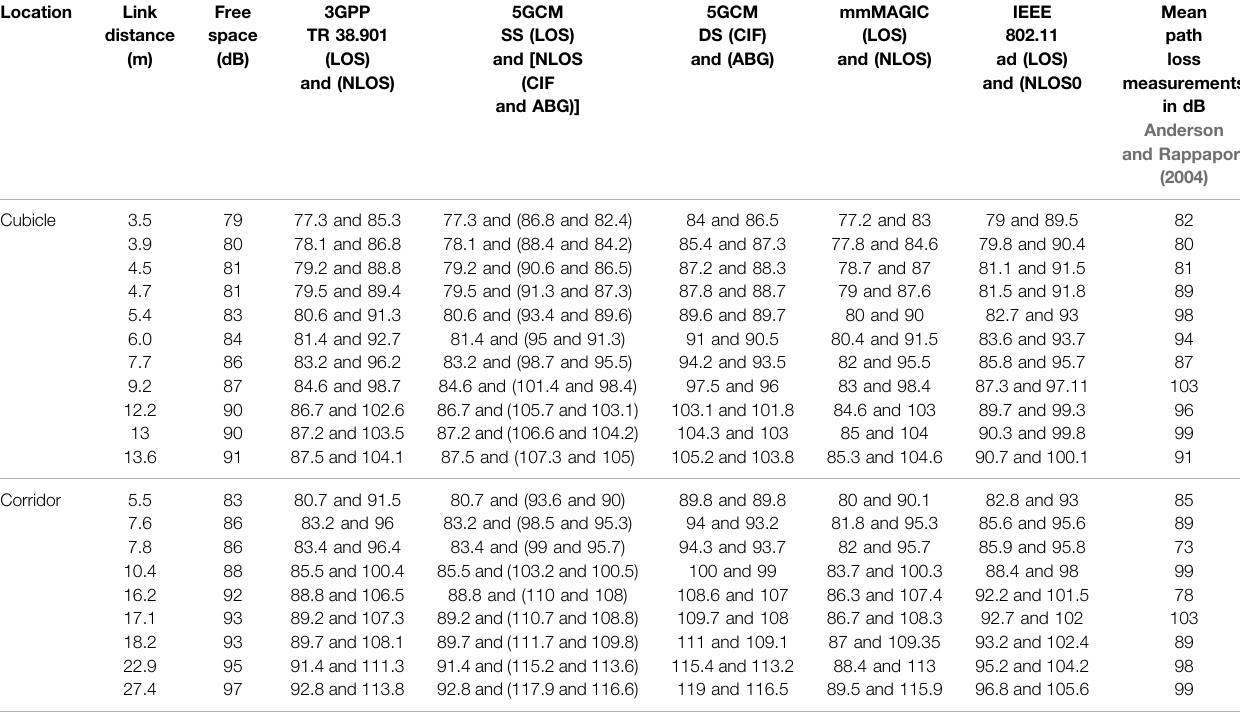
TABLE 4 | Summary of measurement results at 60 GHz compared to propagation models for indoor environments. Location